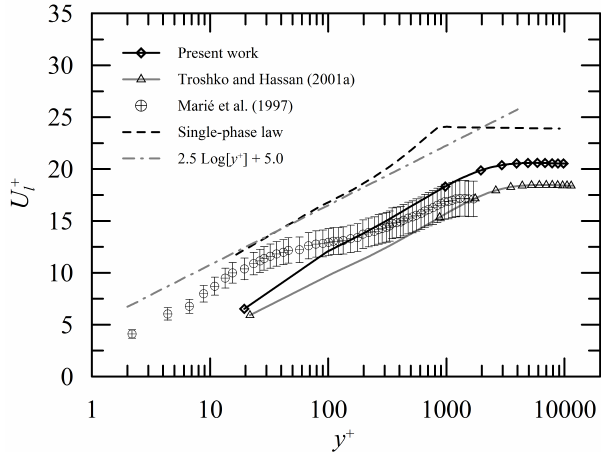
Figure 7 - Mean velocity profiles, α g